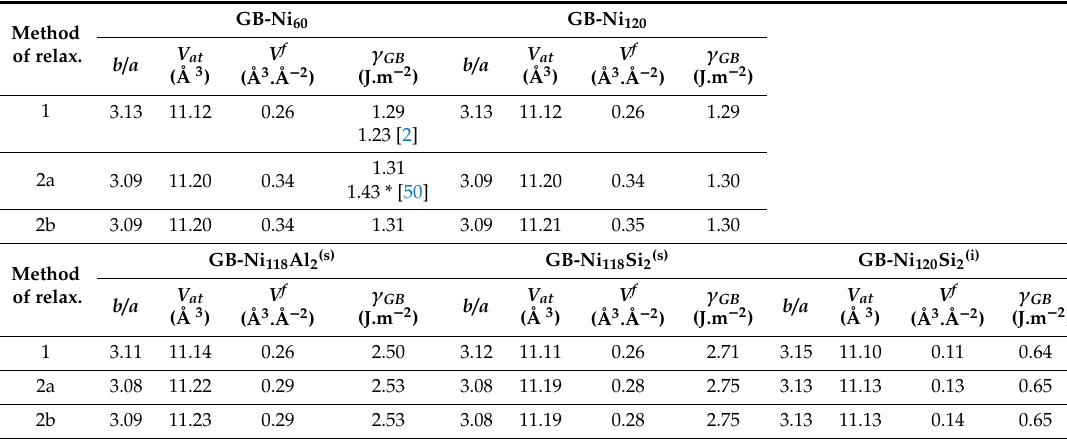
Table 3. Properties of structures with clean and impurity-segregated GBs (equilibrium b / a parameter, volume per atom V at , excess free volume V f and GB energy γ GB ) obtained by di ff erent methods of relaxation. Method 1 is the automatic full relaxation. Method 2 keeps the two lattice parameters (in the plane of the GB) fixed and the lattice parameter perpendicular to the GB is changed by the simultaneous relaxation of atomic positions. The equilibrium structures were determined with respect to (a) minimum energy (Method 2a) or (b) the zero stress along the dimension perpendicular to the GB (Method 2b). Here, b is the supercell lattice constant perpendicular to the GB plane and a is the lattice constant in the plane of the GB (see Figure